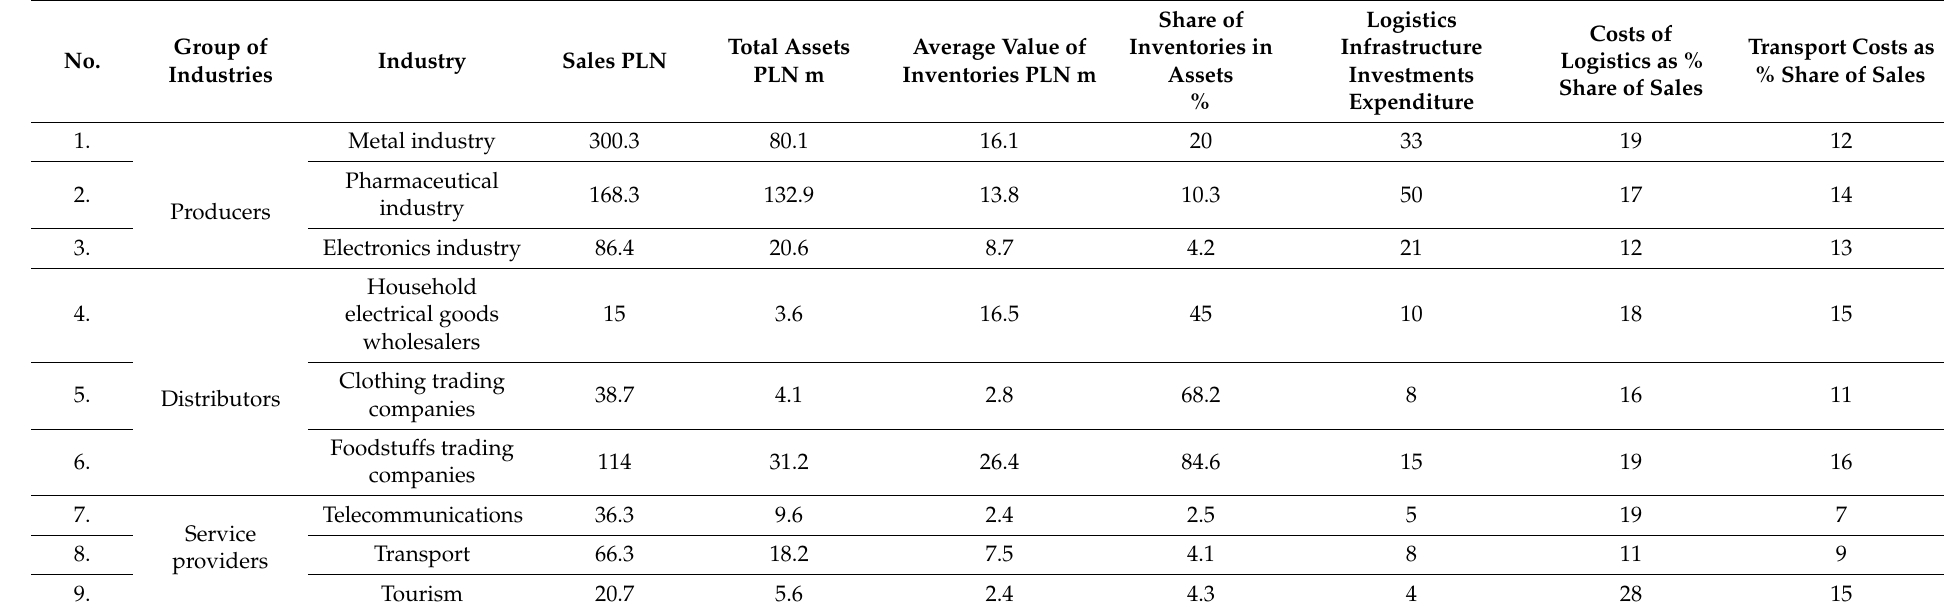
Table 4. Average values characterizing logistics activities in Polish firms over the period of 2000–2018.